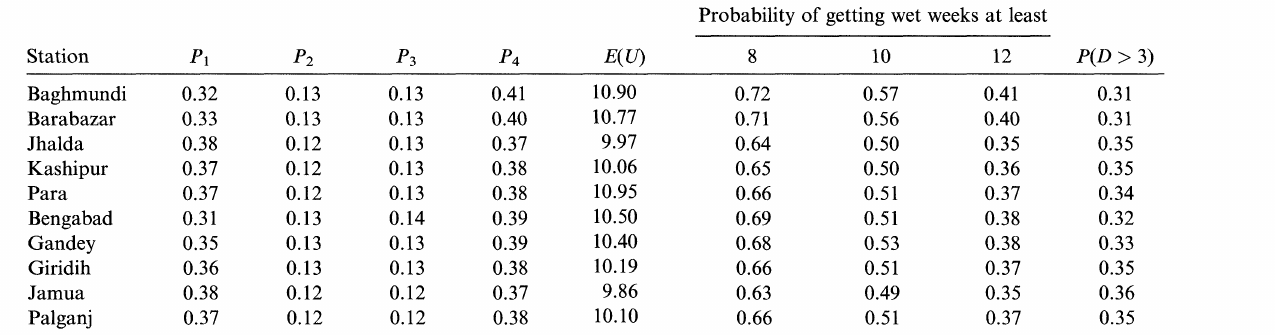
TABLE IV Probability of wet and dry weeks in various stations of Purulia and Giridih districts (Method 2)